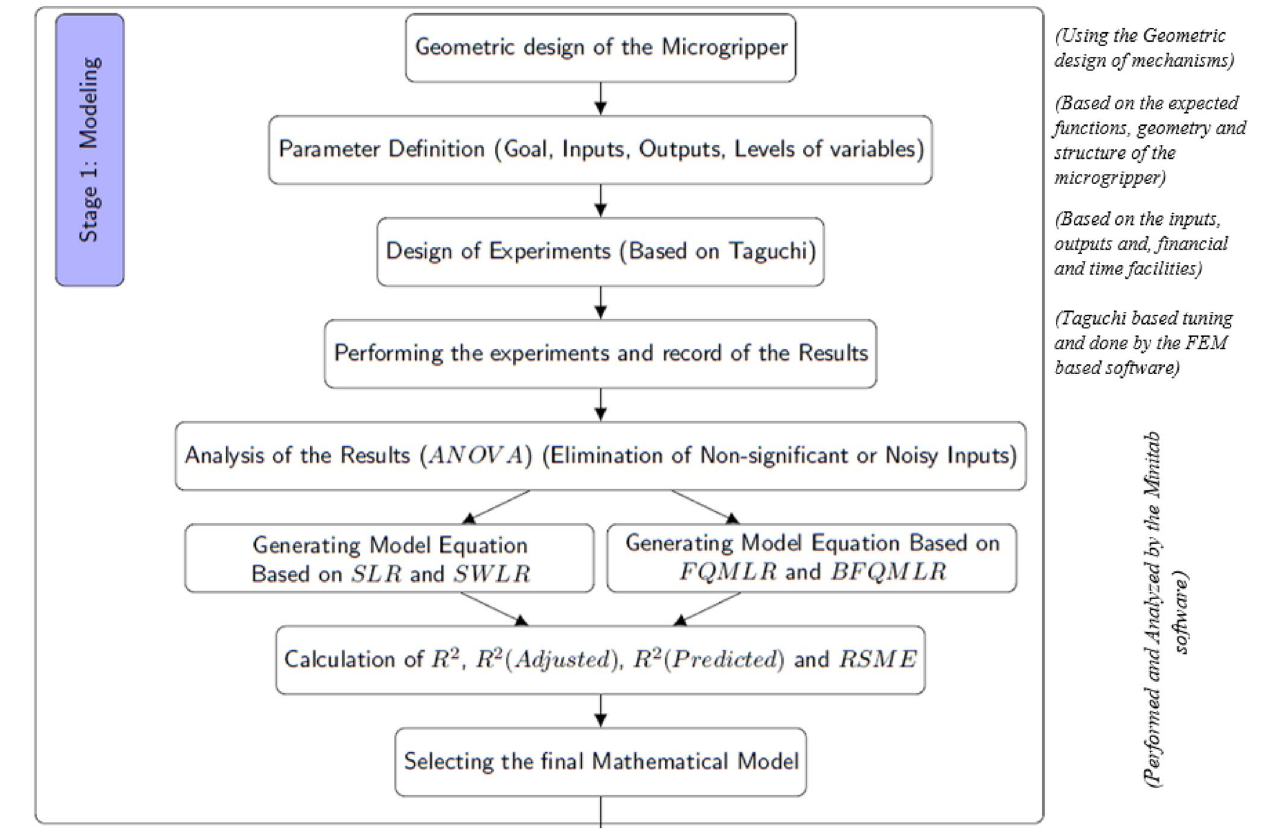
Fig. 5 Proposed optimization algorithm (stage1: